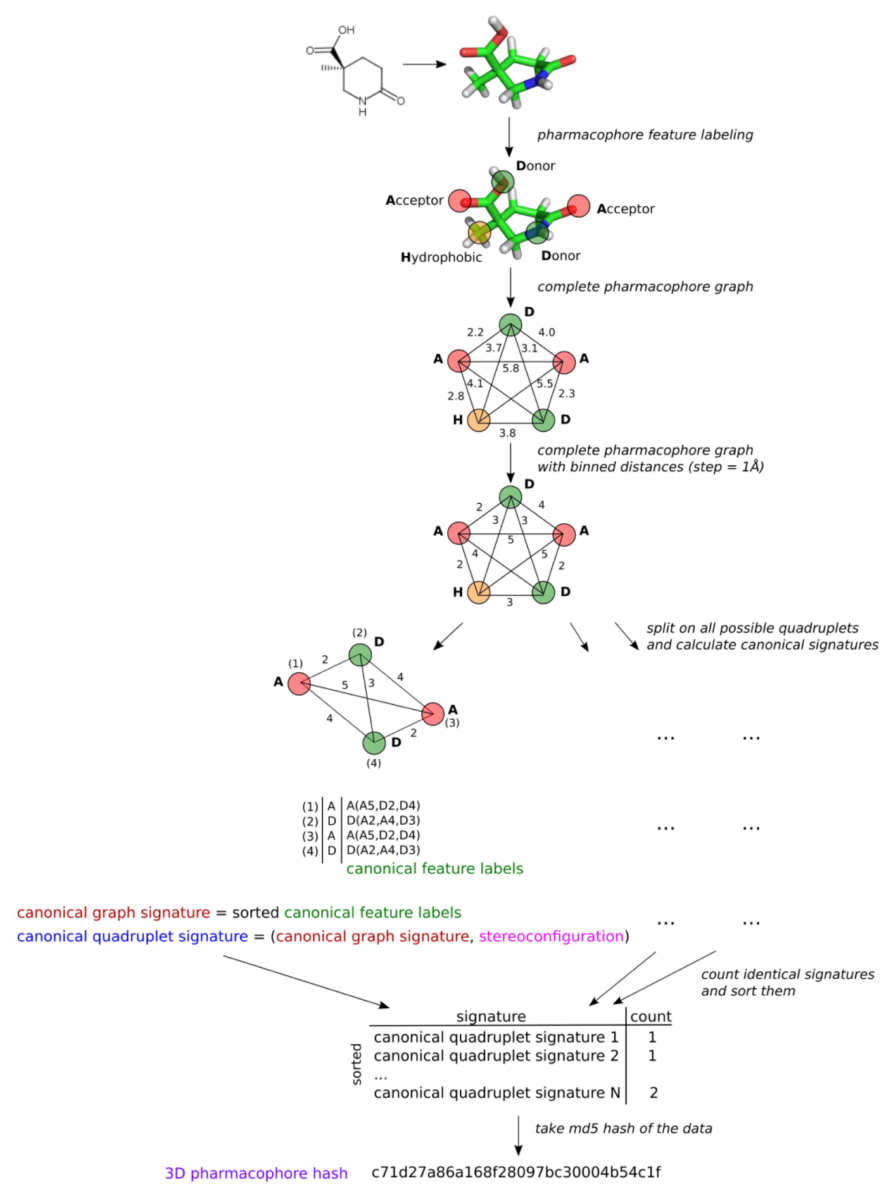
Figure 1. An example of the generation of a 3D pharmacophore